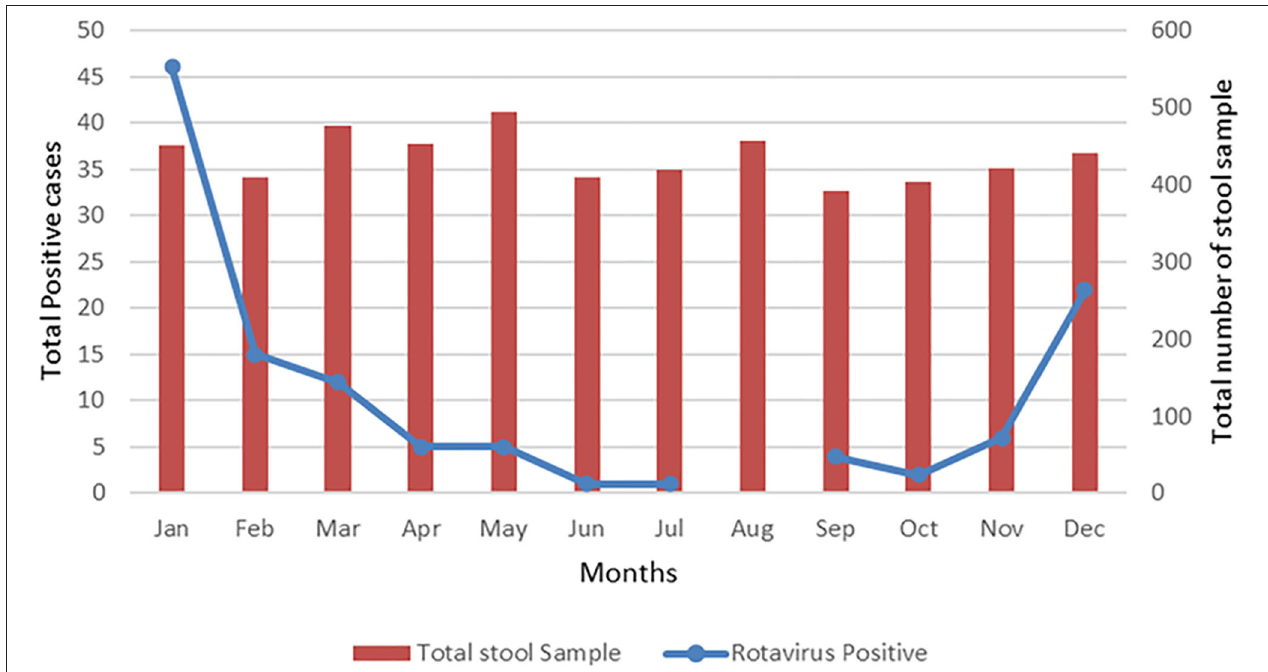
FIGURE 4 | Seasonal variation of rotavirus infection among cohort children. The graph shows the total number of rotavirus infected in different months (blue dots, left axis) of total number of samples collected (red bars, right